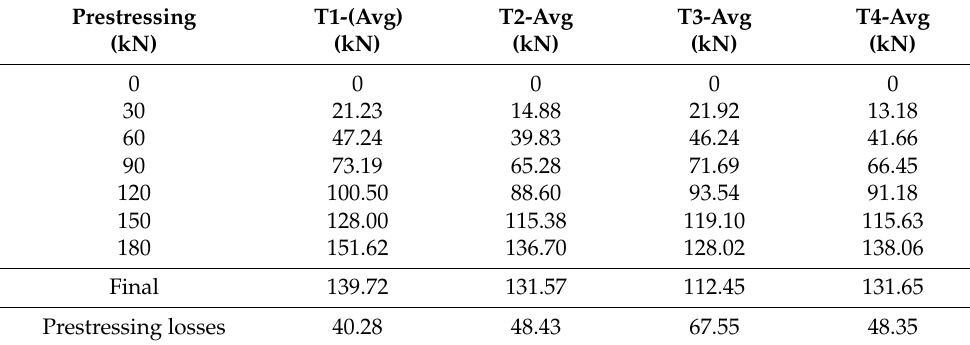
Table 5. Final prestressing of strands T1, T2, T3, and